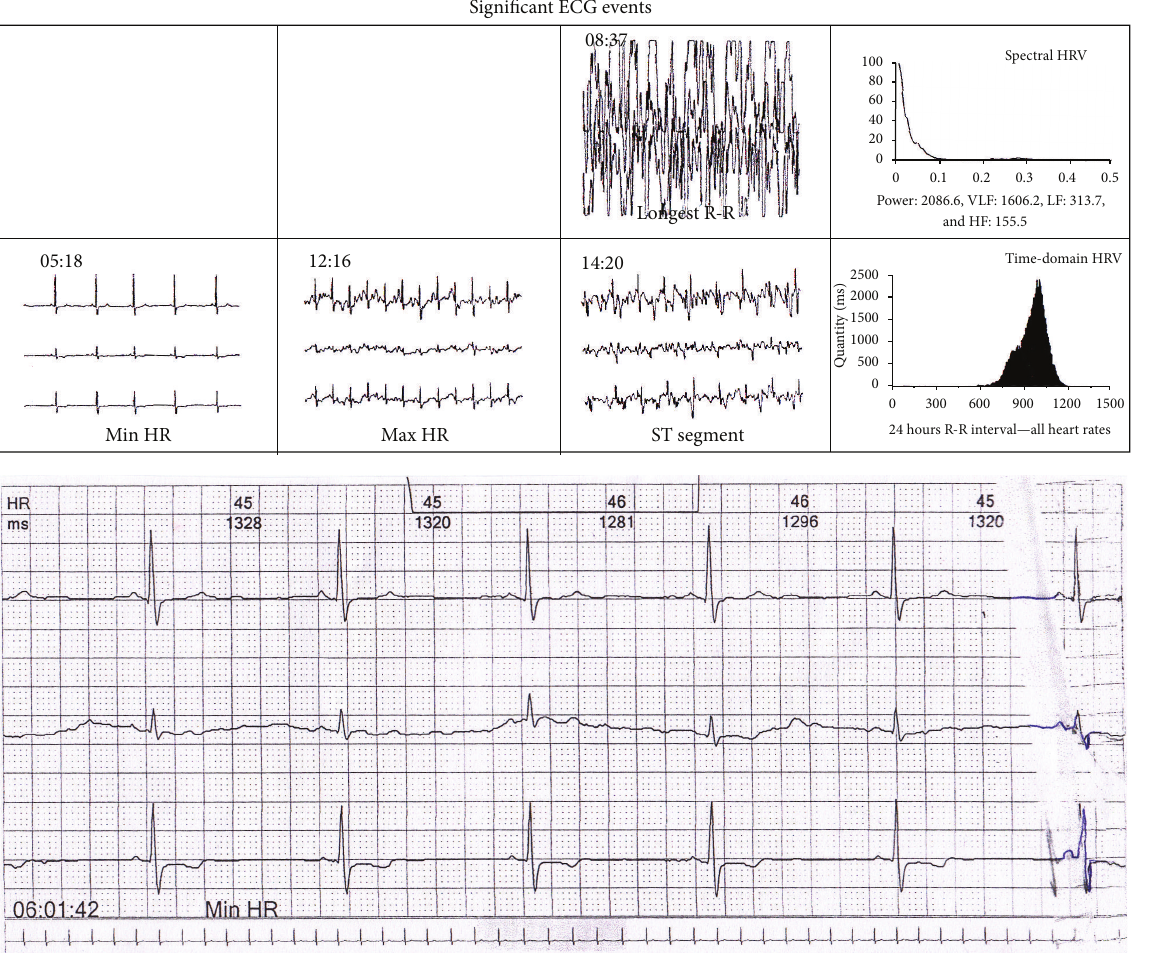
was seen on MRI. Twelve-lead electrocardiogram was taken (Figure